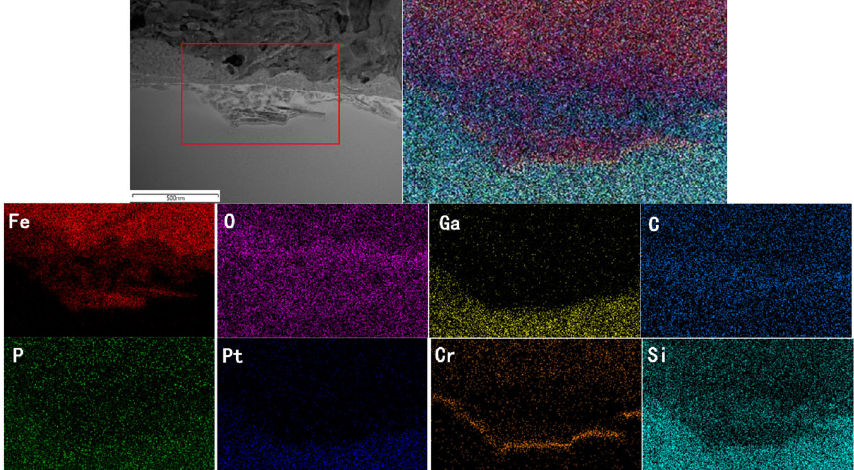
Fig. 24 The distribution of the chemical elements in frictional layer at worn surfaces of